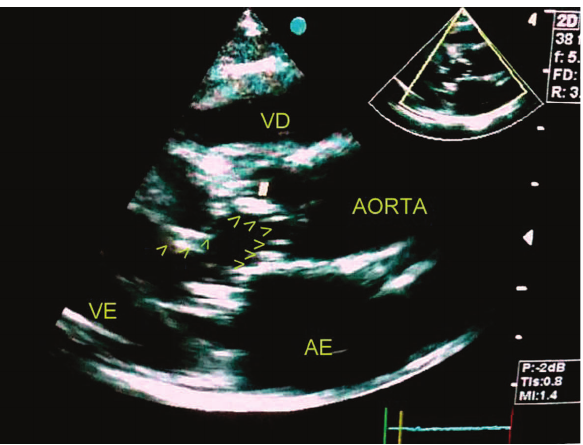
Fig. 2. Aortotomia oblíqua demonstrando o folheto mitral acessório (FMA), sendo suspenso por fios. Ao = aorta, VE = ventrículo